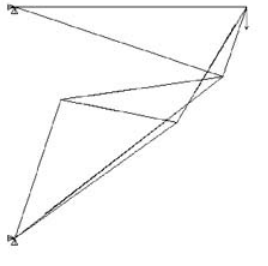
Fig. 10. The best solution obtained with classical GA